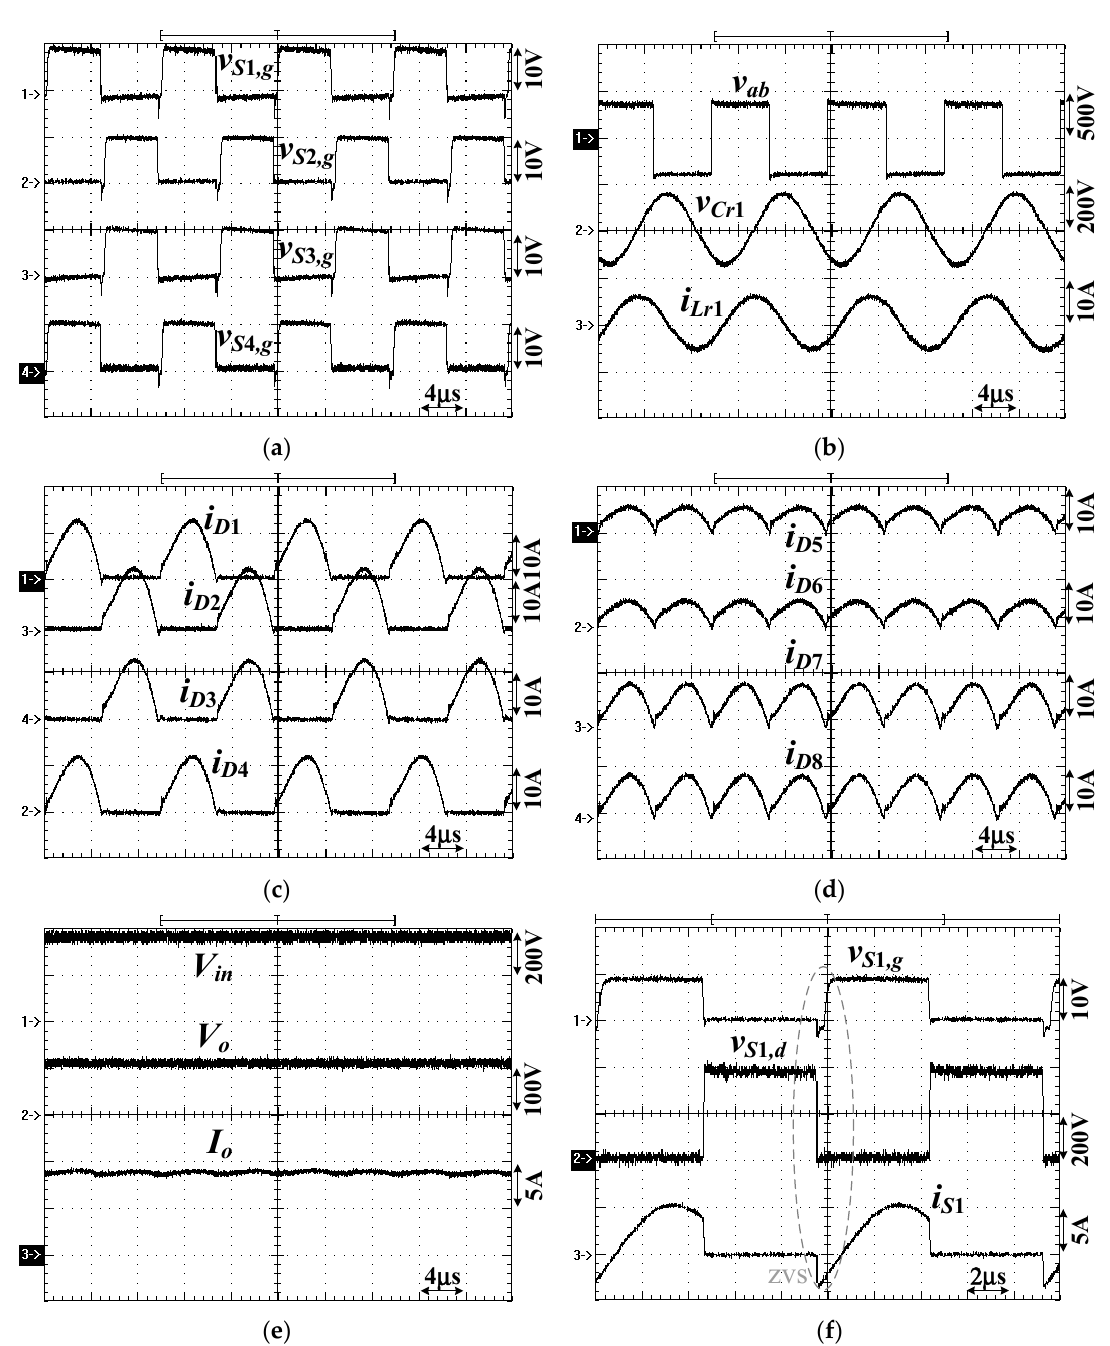
Figure 7. Measured results at 110 V output and 1 kW load under the low output voltage range. ( a ) PWM signals v S 1, g ~ v S 4, g ; ( b ) v ab , v Cr 1 , i Lr 1 ; ( c ) diode currents i D 1 ~ i D 4 ; ( d ) diode currents i D 5 ~ i D 8 ; ( e ) V in , V o , I o ; and ( f ) v S 1 ,g , v S 1 ,d , i S 1 .